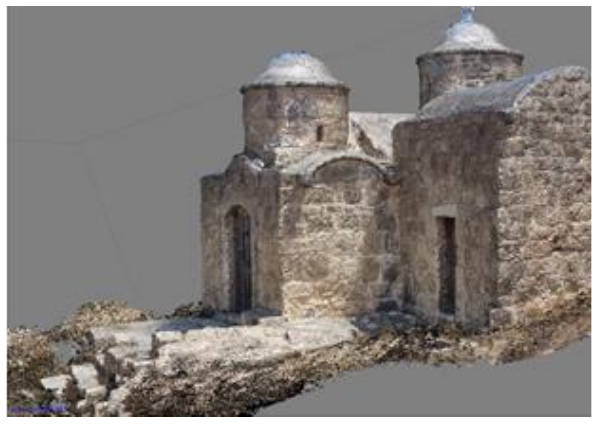
Figure 4: 3D model of Ayia